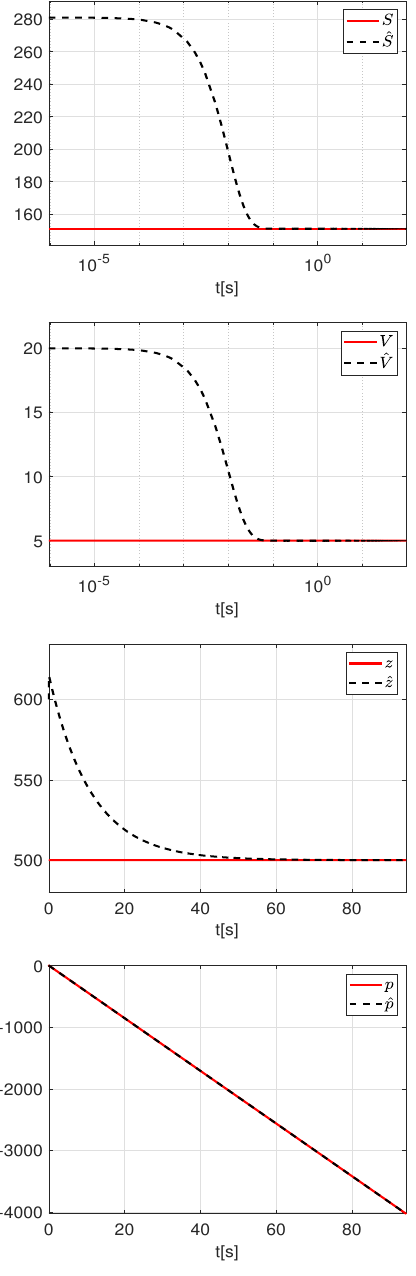
Figure 1. Open-Loop trajectories for the gas piston model and the ob-